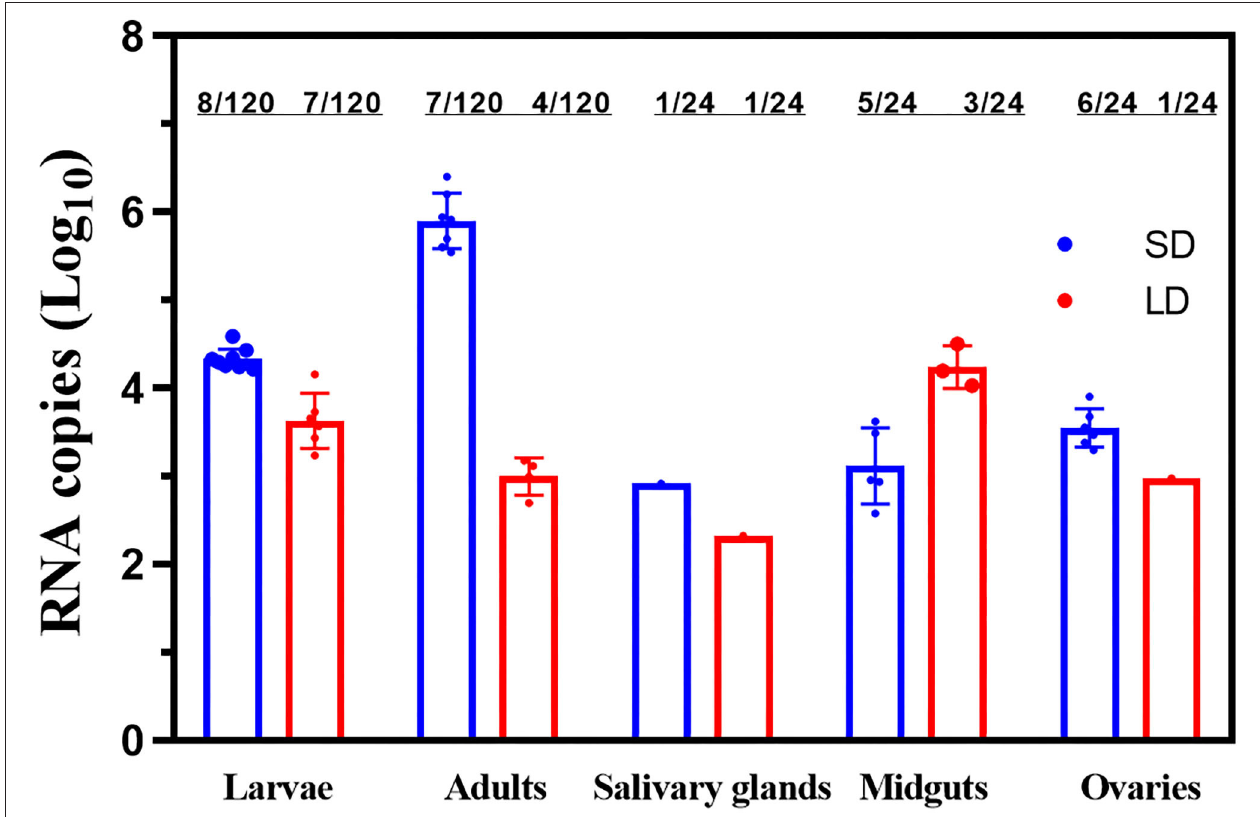
FIGURE 6 | ZIKV RNA copy number in F1 larvae, F1 adults and saliva, salivary glands, midguts, and ovaries of F1 progeny females. LD, a non-diapause-inducing long-day photoperiod; SD, diapause-inducing short-day photoperiod. Each point represents one positive tissue.